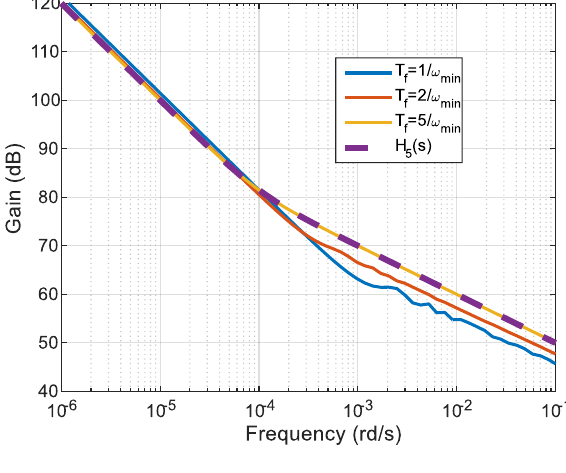
Figure 3. A comparison of gain diagrams of 𝐻 𝜔 𝑚𝑖𝑛 = 0.0001 rd/s , and 𝜔 𝑚𝑎𝑥 = 1000 rd/s.